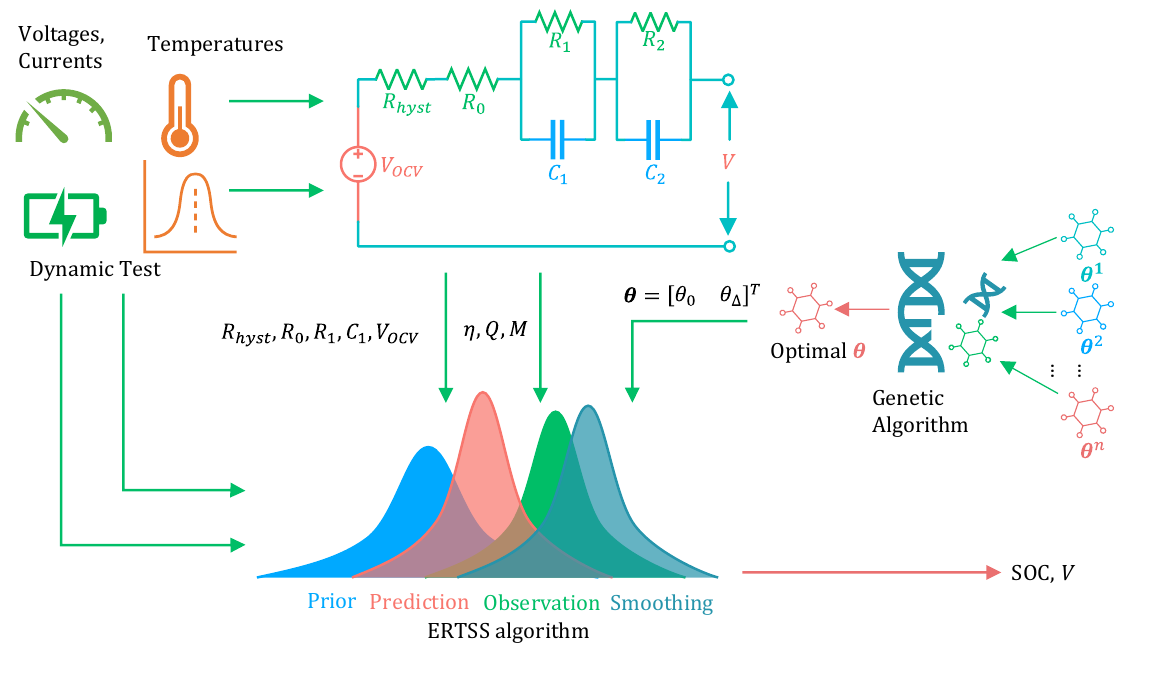
Figure 3. System